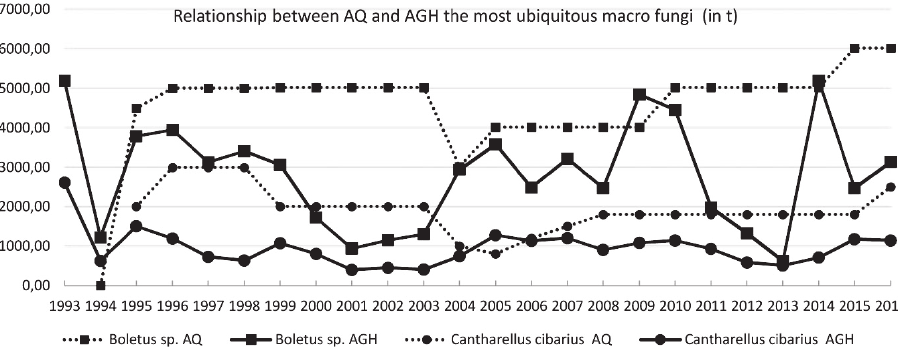
Figure 4. The estimation and demand of the most ubiquitous mushrooms trade in Serbia. AQ and AGH according to INCS for porcini Boletus sp. ( B. edulis , B. aereus , B. reticulates and B. pinophilus ) and Cantharellu scibarius .